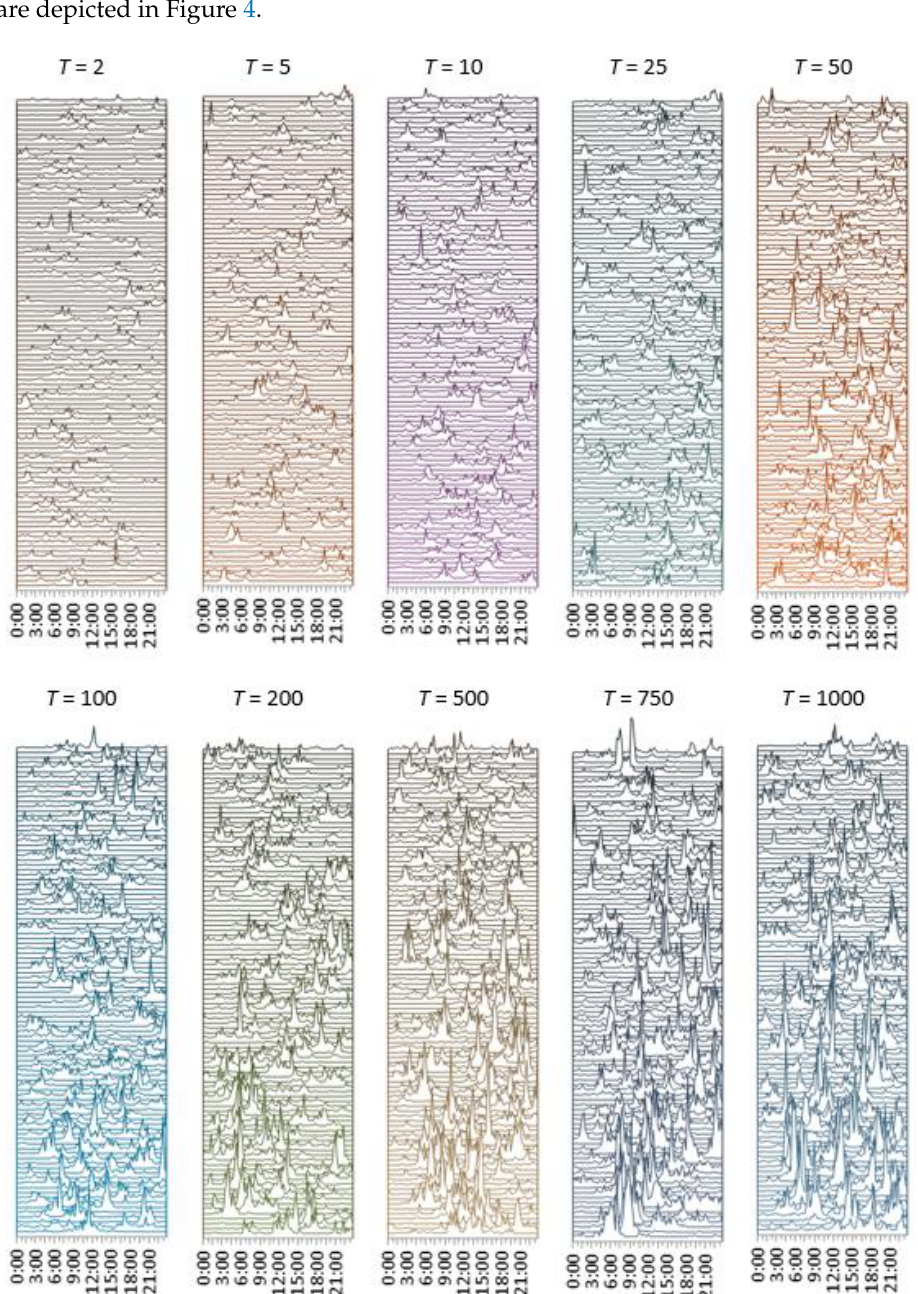
Figure 4. Synthetically generated 24 h design hyetographs (time interval 15 min), grouped by return period 𝑇 (years) (100 synthetic hyetographs per 𝑇 ).